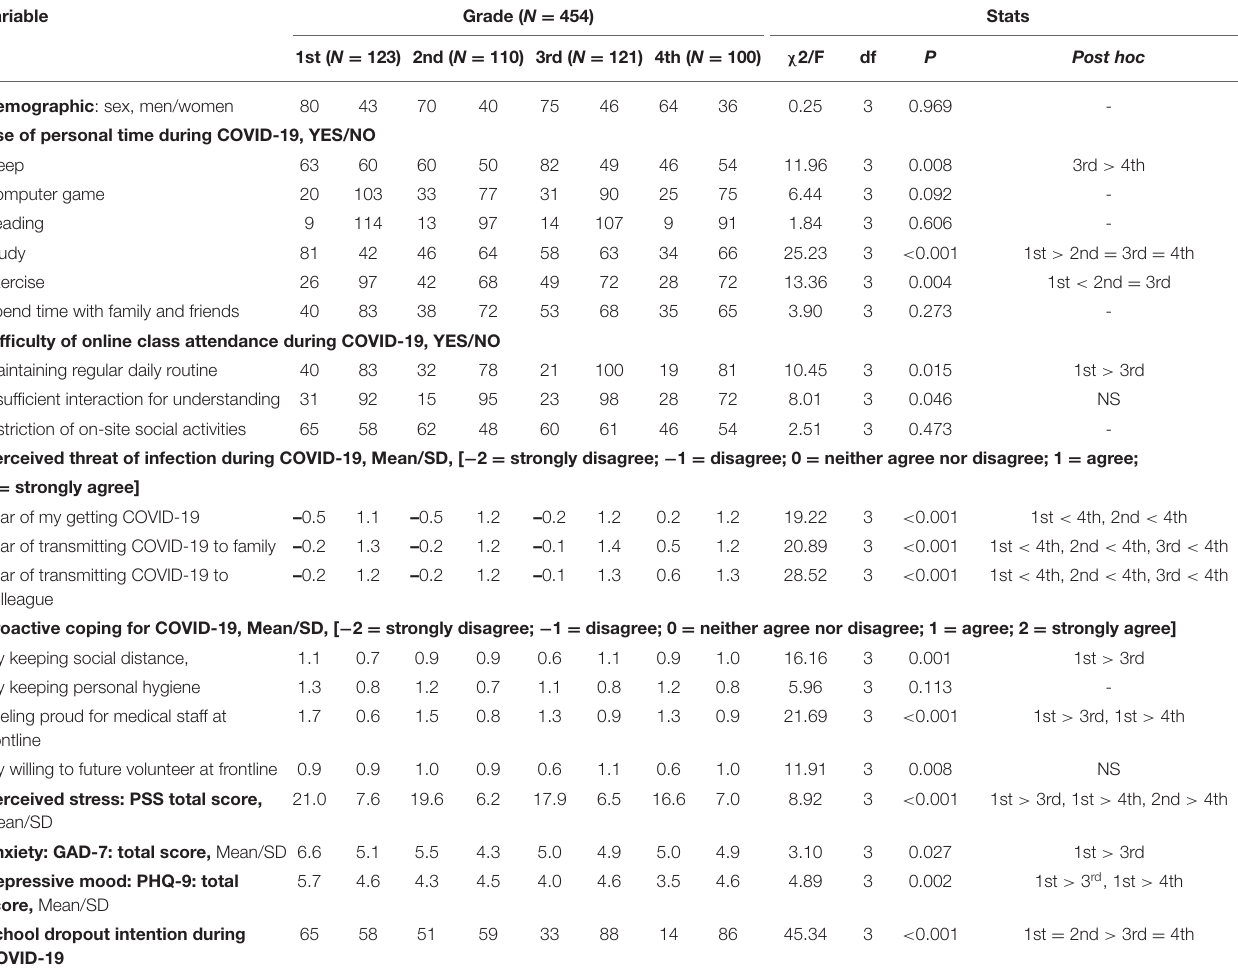
TABLE 1 | Demographic and clinical characteristics: sub-grouped for grade.